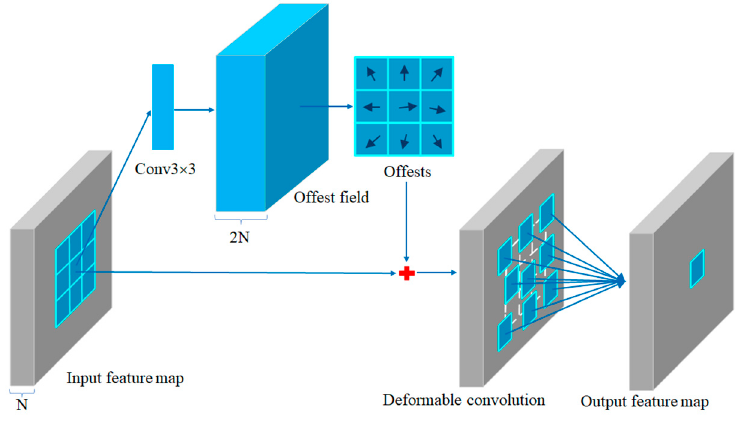
Figure 4. The architecture of deformable convolution.